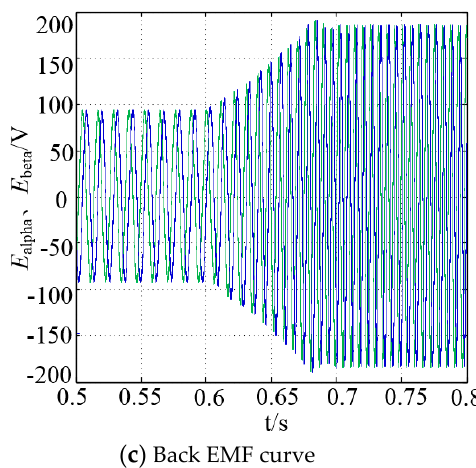
Figure 9. Simulation response curves of the STA-SMO with APEC.